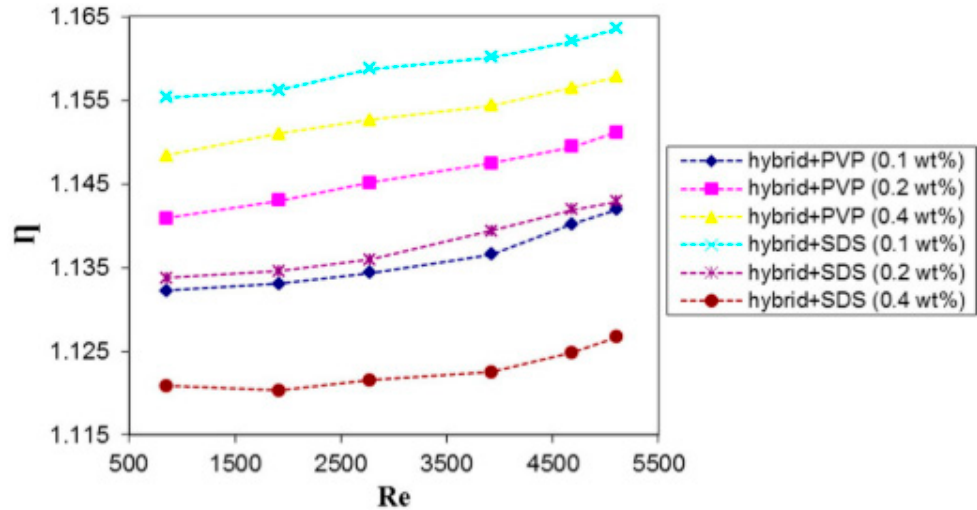
Figure 9. Influence of surfactants (PVP and SDS) on thermal efficiency of hybrid nanofluids in a helical coil heat exchanger [58].